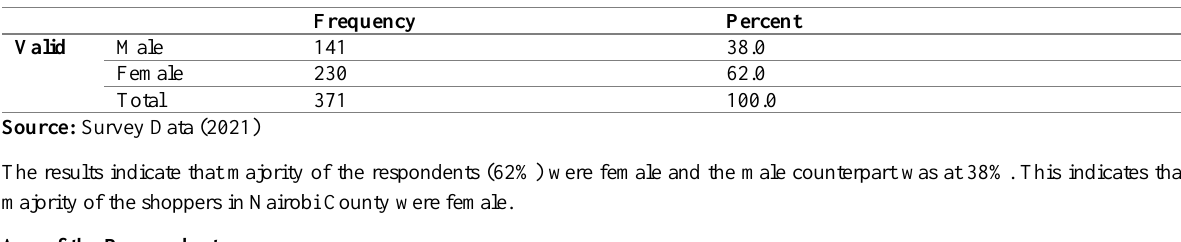
Table 2: Respondent’s Age Group